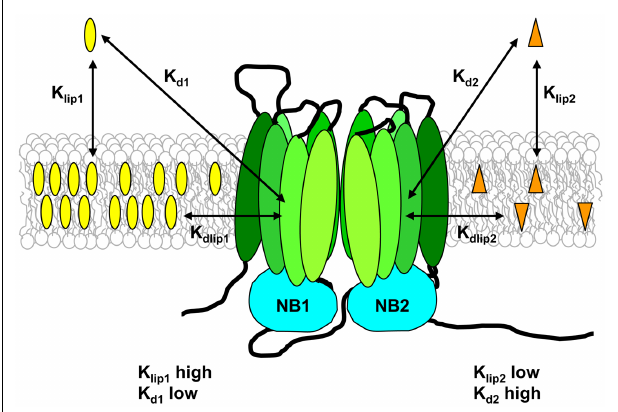
FIGURE 4 | Substrate–membrane relationships and their role in drug binding to Pgp . Pgp substrates partition into the lipid bilayer from the aqueous phase in accordance with their lipid–water partition coefficients ( K lip ).The drug on the left of the figure has a high K lip value and thus reaches a high concentration in the lipid phase, whereas the drug on the right of the figure has a low K lip value, and therefore has a much lower membrane concentration. K lip values measured for Pgp substrates are typically in the range 300–20,000.The apparent binding affinity ( K d ) is determined using aqueous drug concentrations, and depends on both drug partitioning into the lipid phase and drug binding to the transporter from within the membrane.The intrinsic affinity of Pgp for binding substrate from the lipid bilayer ( K dlip ) can be estimated from the values of K lip and K d , and is relatively low, in the range